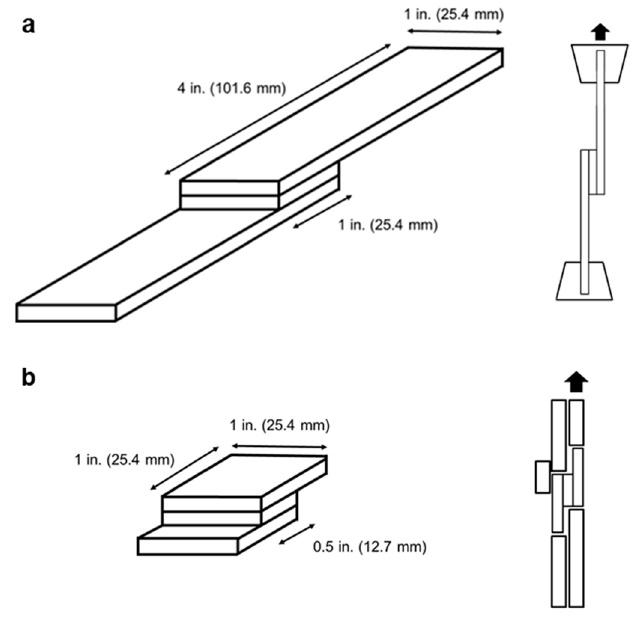
Figure 3. Dimensions and test configuration for ( a ) a single-lap shear specimen according to ASTM D5868 and ( b ) a block shear specimen according to ASTM D4501.